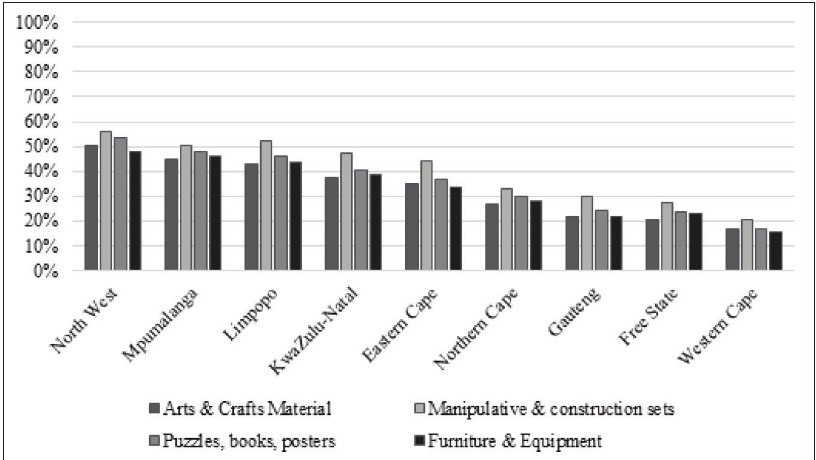
Figure 5: Inadequate learning and teaching support material (LTSM),